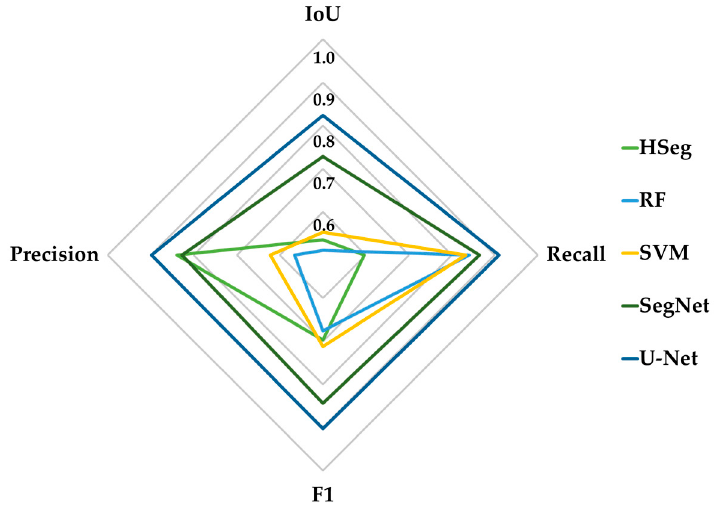
Figure 5. Summary of the precision, recall, F-measure (F1), and Intersection of Union (IoU) results obtained with all five segmentation methods.